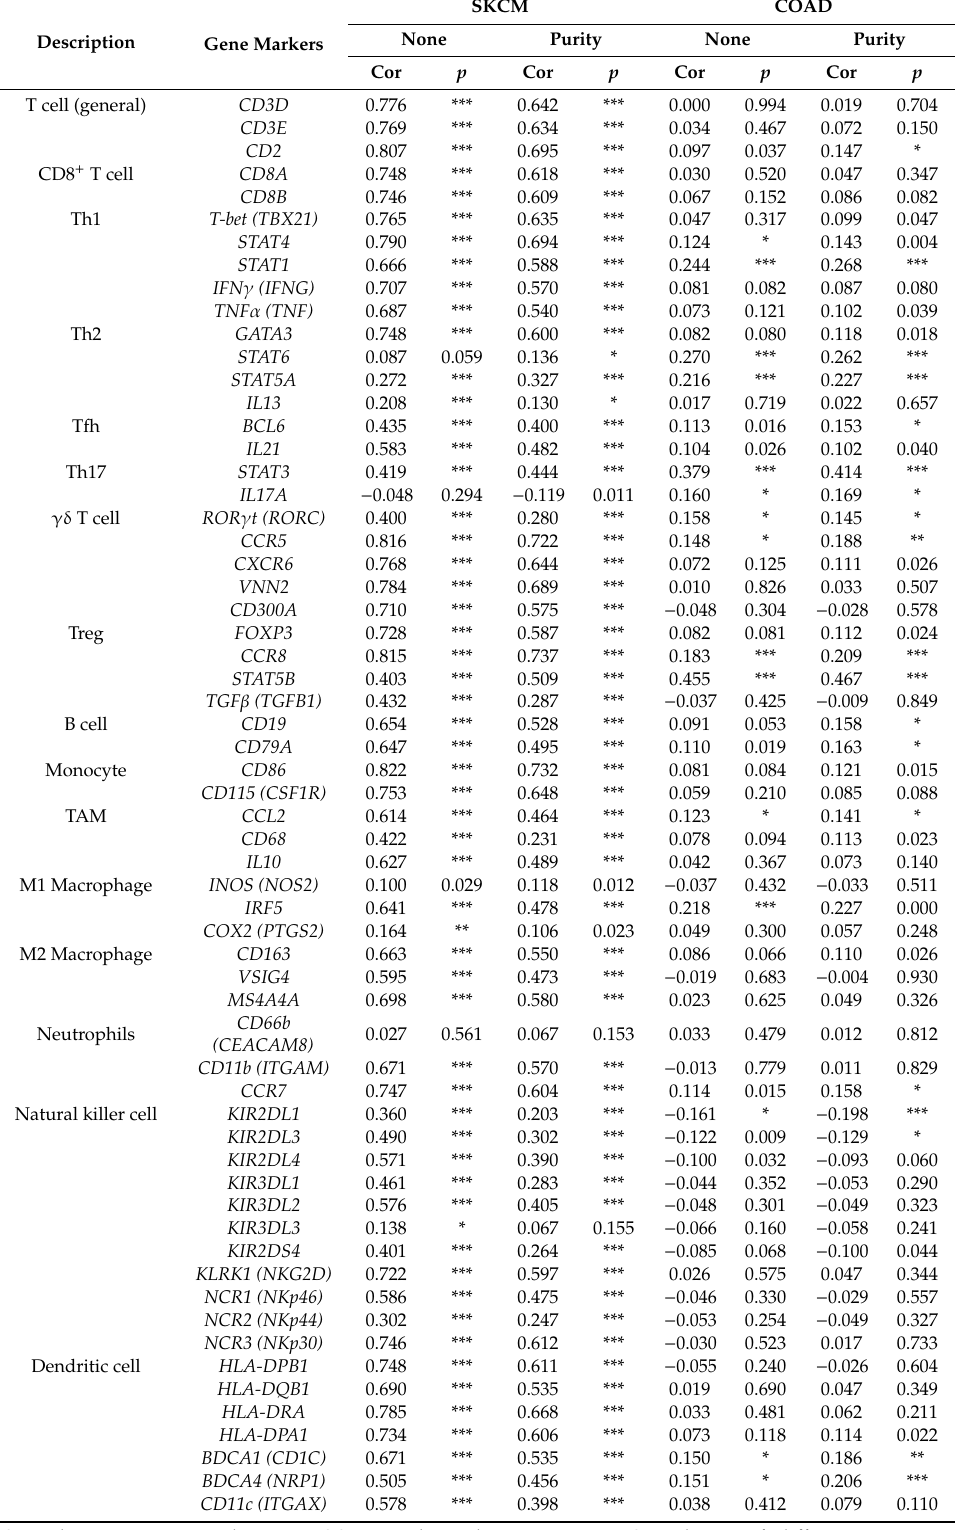
Table 1. Correlation between Ly75 and markers of various immune cells in TIMER.